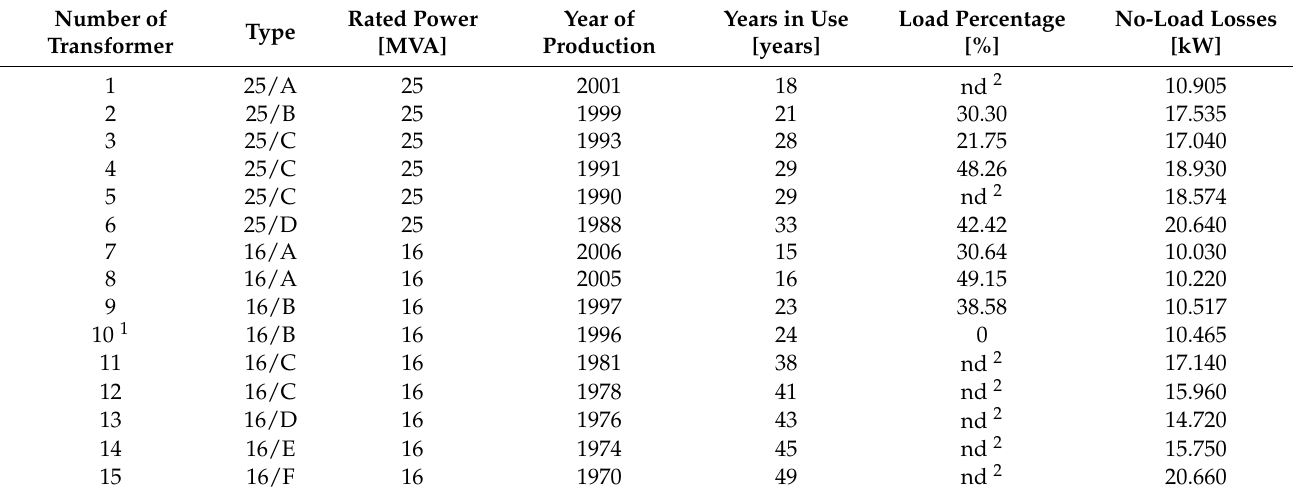
of the vibration acceleration in specific frequency bands [27]. Measurements are carried out via a sensor (piezoelectric accelerometer), which is attached to the transformer tank with